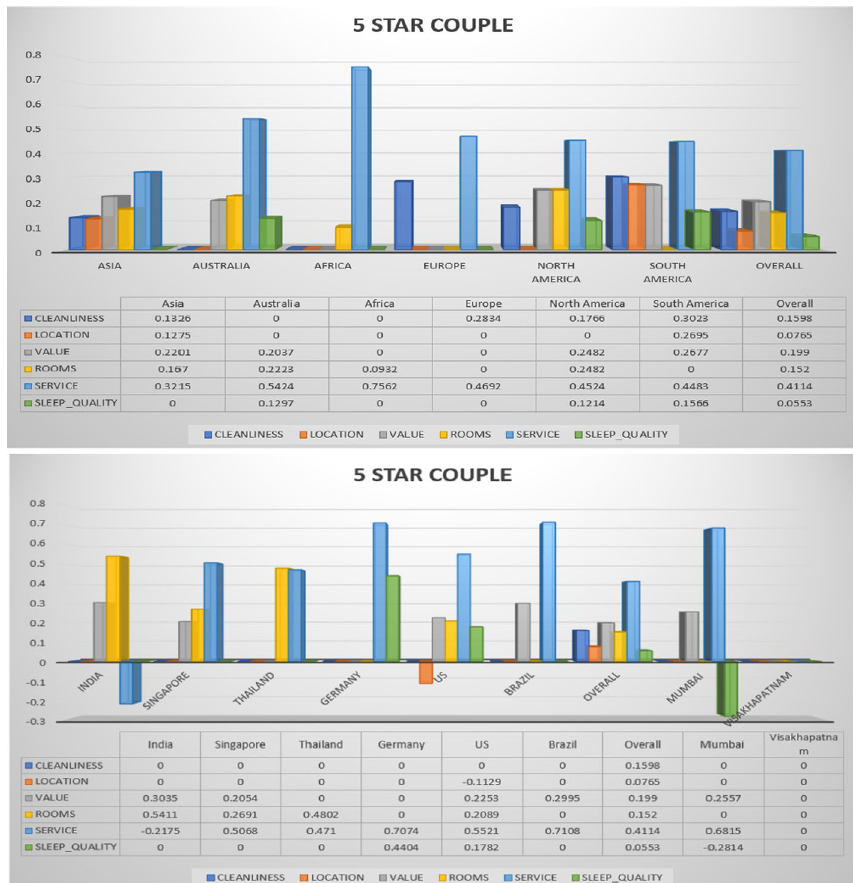
Fig. 6 Hotel class: 5 star, Trip Type: Travelled as a couple (continent, country and